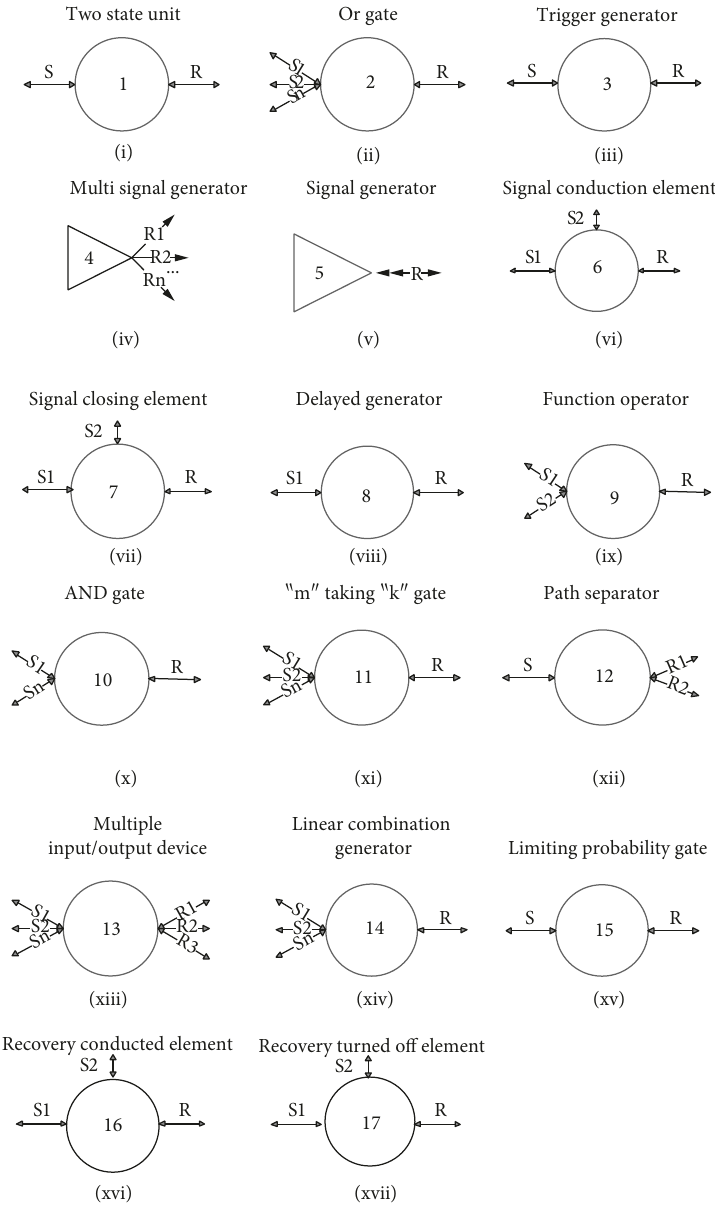
Figure 4: Basic operators of the GO